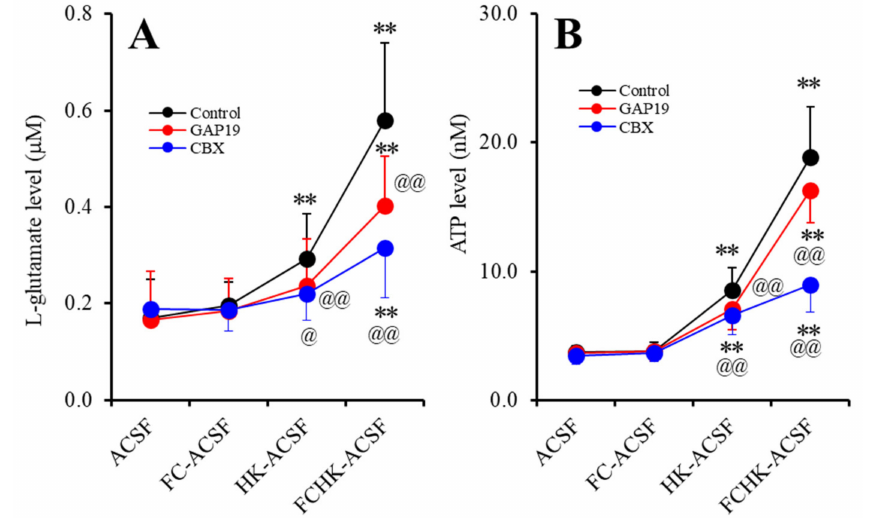
Figure 1. E ff ects of the extracellular Ca 2 + and K + and hemichannel inhibitors carbenoxolone (CBX; a non-selective inhibitor, 100 µ M) and GAP19 (a selective Cx43 inhibitor, 20 µ M) on the astroglial release of ( A ) l -glutamate and ( B ) adenosine triphosphate (ATP). Primary cultured astrocytes